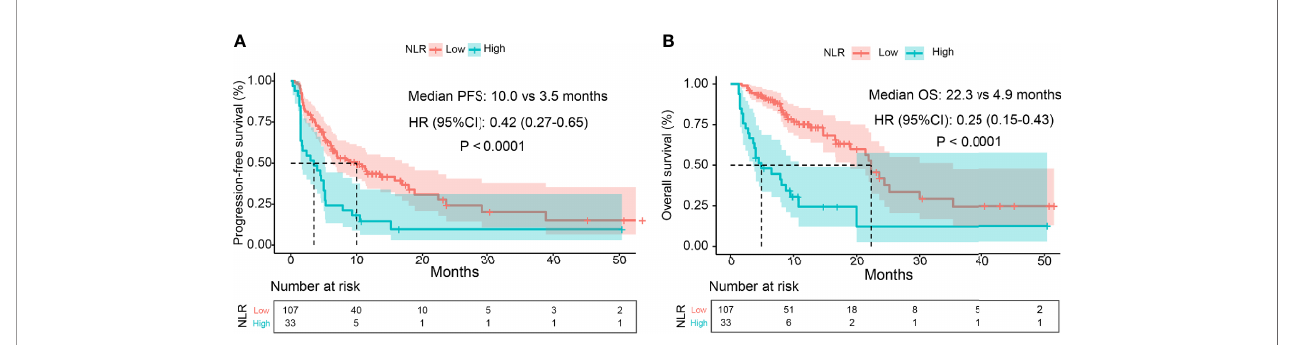
FIGURE 4 | Kaplan-Meier curves of PFS and OS. Part (A) is the curve of PFS and part (B) is the curve of OS. TABLE 4 | Differences of patients ’ characteristics between two groups.